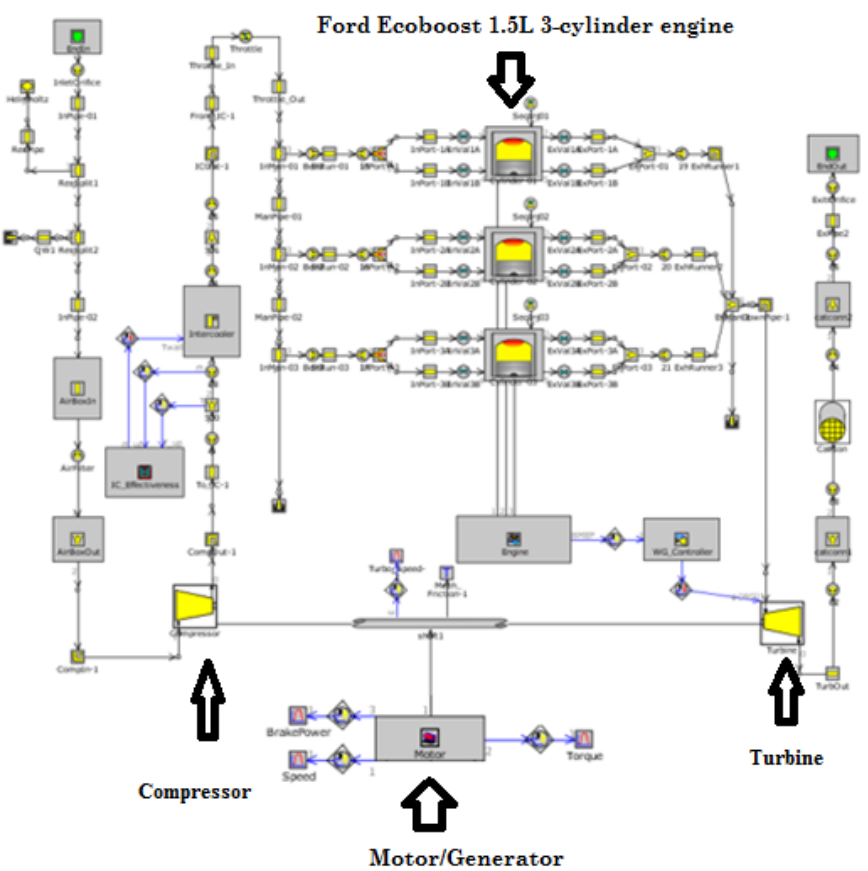
Figure 6. Model of the Ford Ecoboost 1.5L electrically assisted turbocharged engine.